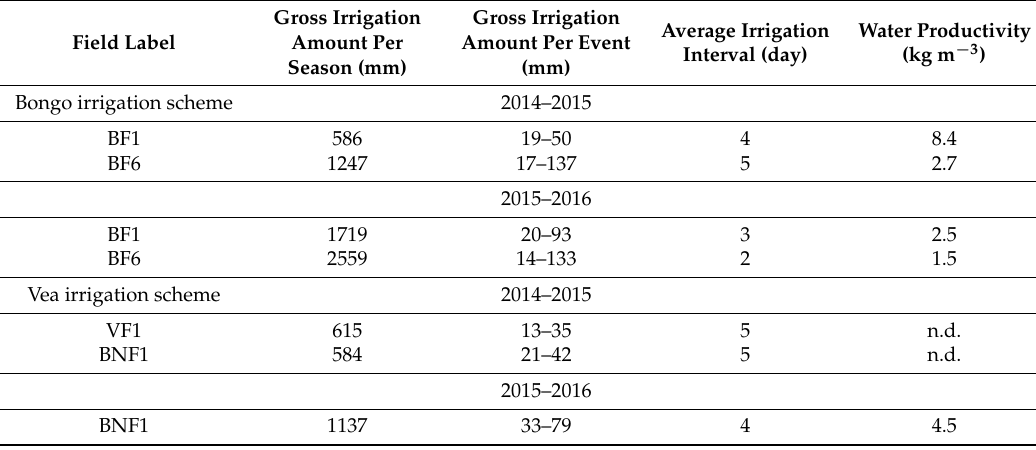
Table 4. Observed field-level irrigation practices and water productivity for tomato in the Bongo and Vea irrigation schemes during the dry seasons.